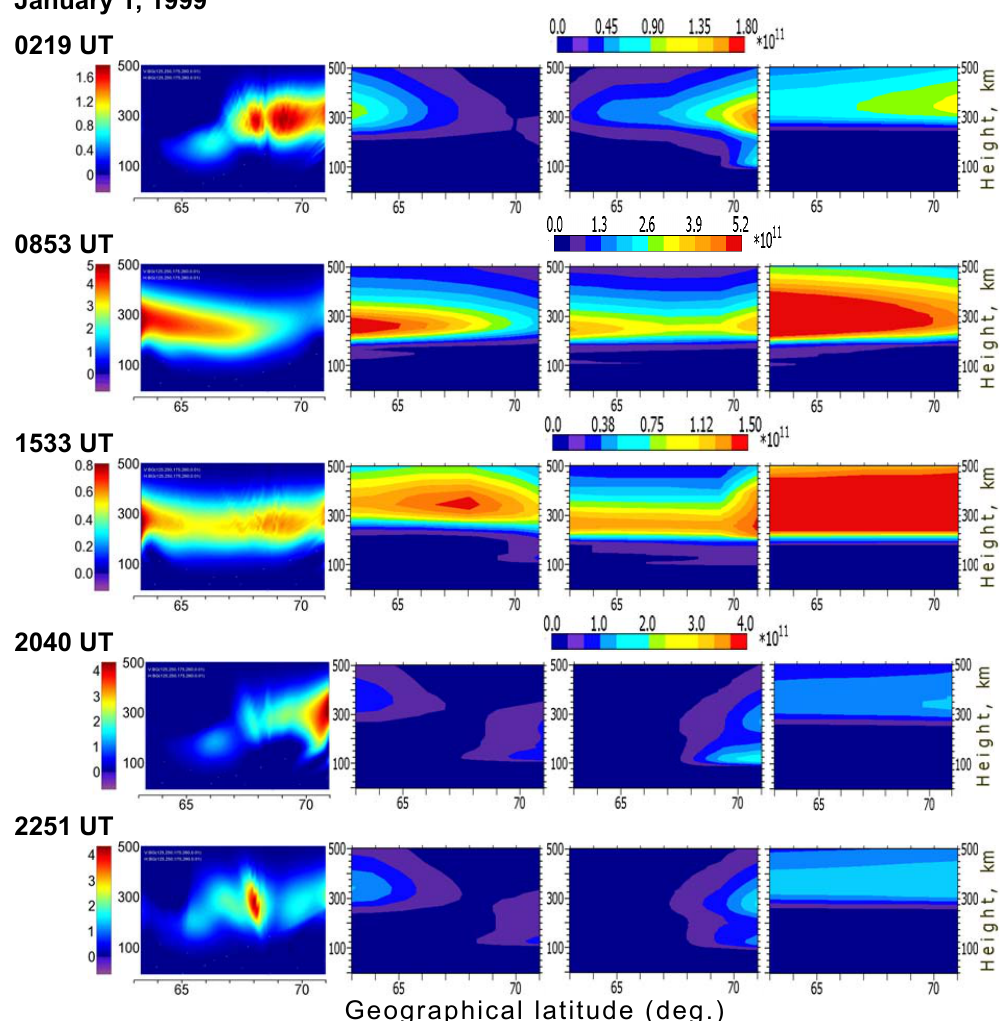
Fig. 3. Tomography images of the electron density (m − 3 ) in the vertical plane over the receiver chain (left column) obtained for the observa- tional events on 11 January 1999 (in UT) and the corresponding electron density distributions derived from the models (next three columns from left to right represent the theoretical model UAM, empirical RIM-88 and IRI-95 models, accordingly). All the model calculations were performed in the plane along the geomagnetic meridian of 3 = 125 ◦